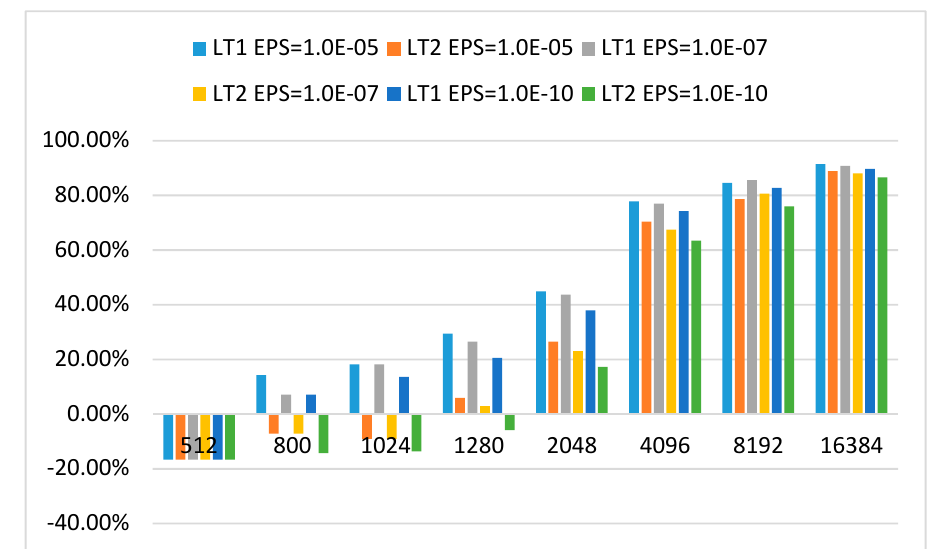
Figure 7. Speedup of LT1 and LT2 with CMAX = 64 compare to LT0 (LT0 is the algorithm using DGEMM, LT1 is the butterfly algorithm and LT2 is the proposed method, EPS is desired precision in interpolative decomposition, CMAX is the number of columns in each sub-matrix on level 0).